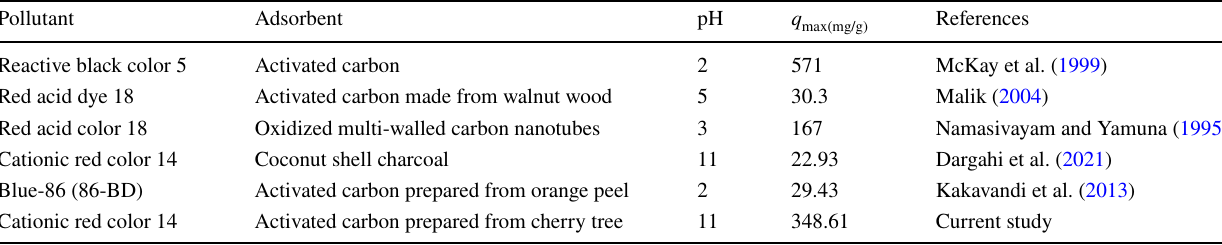
Table 5 Comparison of q e of different ACs for dye adsorption